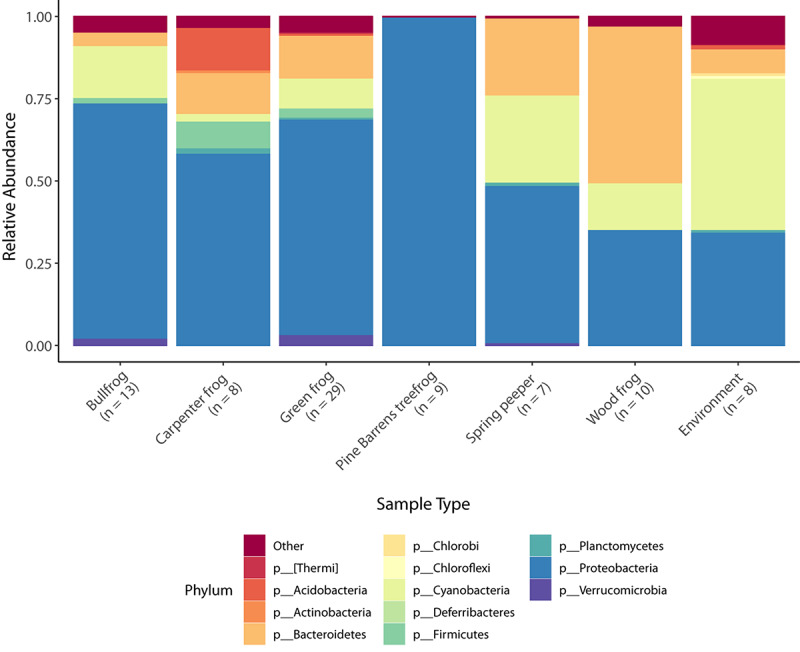
Taxonomic bar plots of mean relative abundance of bacteria (phylum level) across species and in the environment. Phyla comprising less than 5% relative abundance are grouped together in the “other” category.